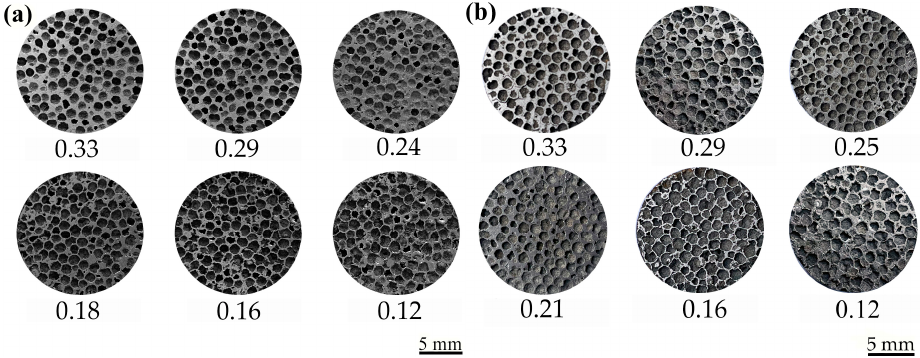
Figure 6. The cell morphology of the SSFs with different relative densities: ( a ) 304; ( b ) 430.